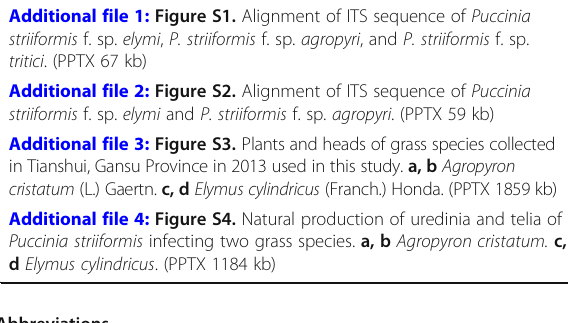
Additional file 1: Figure S1. Alignment of ITS sequence of Puccinia striiformis f. sp. elymi , P. striiformis f. sp. agropyri , and P. striiformis f. sp.